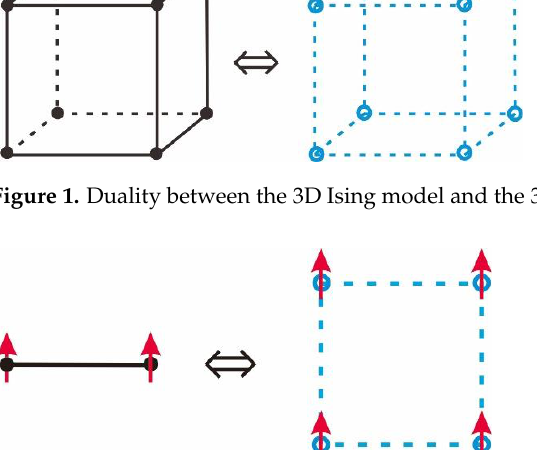
Figure 2. Mapping between a two-spin interaction for a link in the 3D Ising model and a four-spin interaction for a plaquette in the 3D Z 2 lattice gauge model.